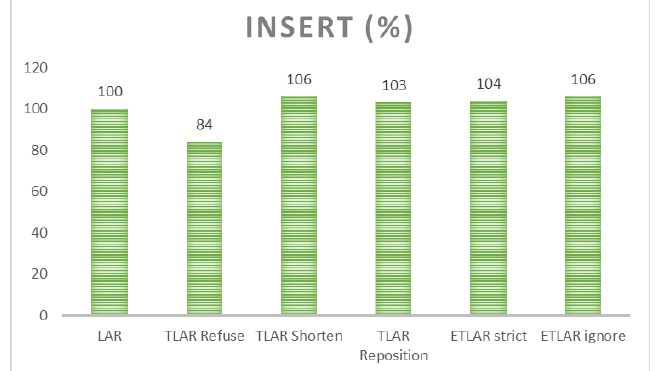
Figure 22. Insert—Log Ahead Rule (LAR), Temporal Log Ahead Rule (TLAR), Extended Temporal Log Ahead Rule (ETLAR).